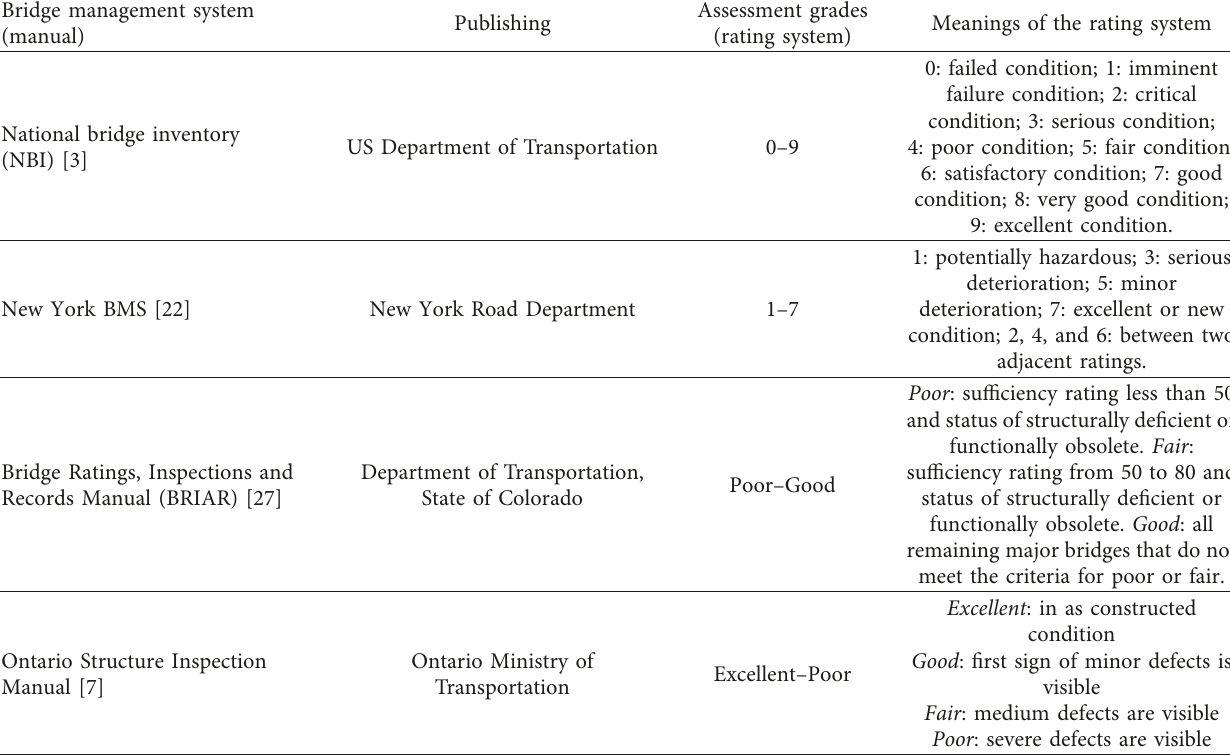
Table 1: Common North America and Europe bridge management systems with their bridge condition assessment.